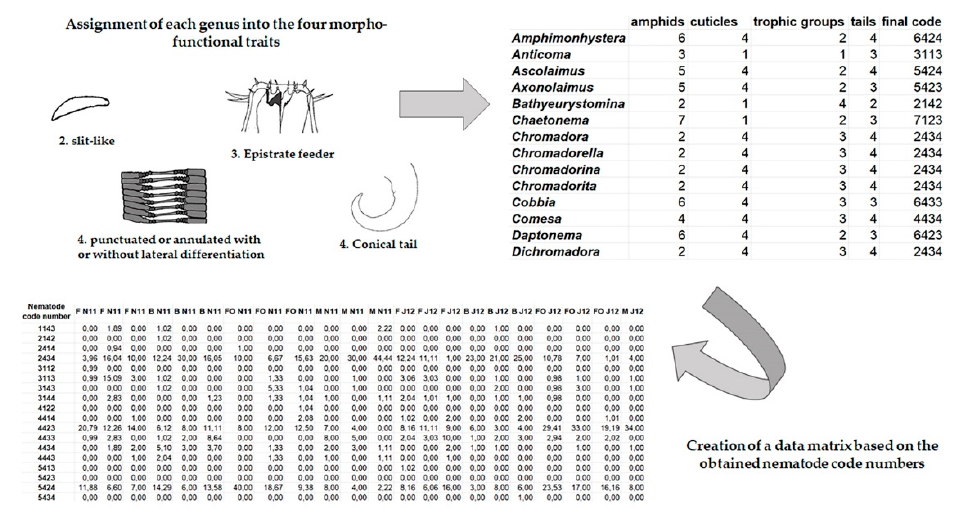
Figure 6. Assignment of each genus in the four morpho-functional traits and creation of the data matrix based on the combination of morpho-functional traits.